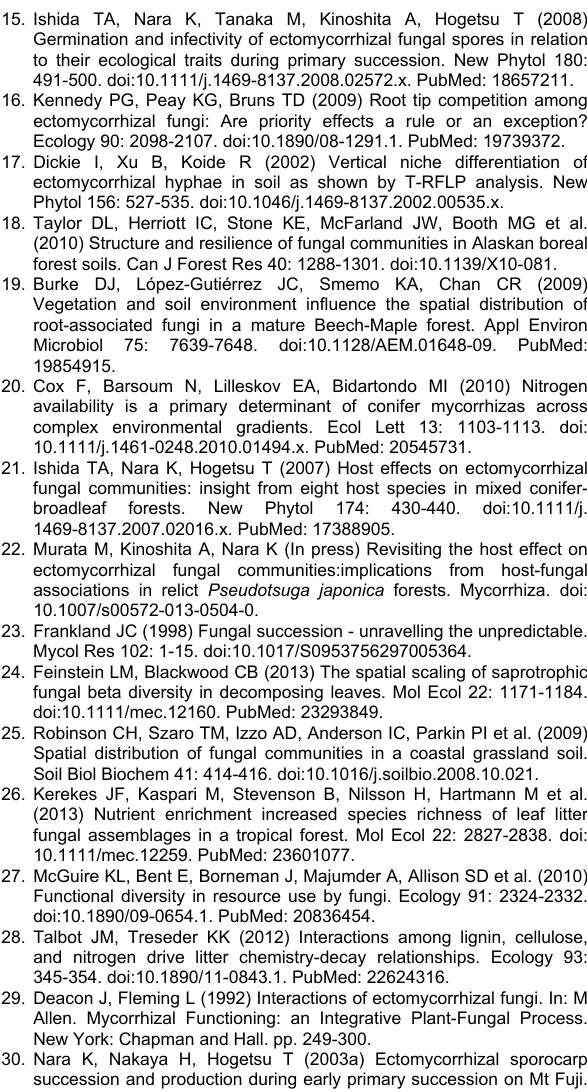
Table S5. Potentially EM